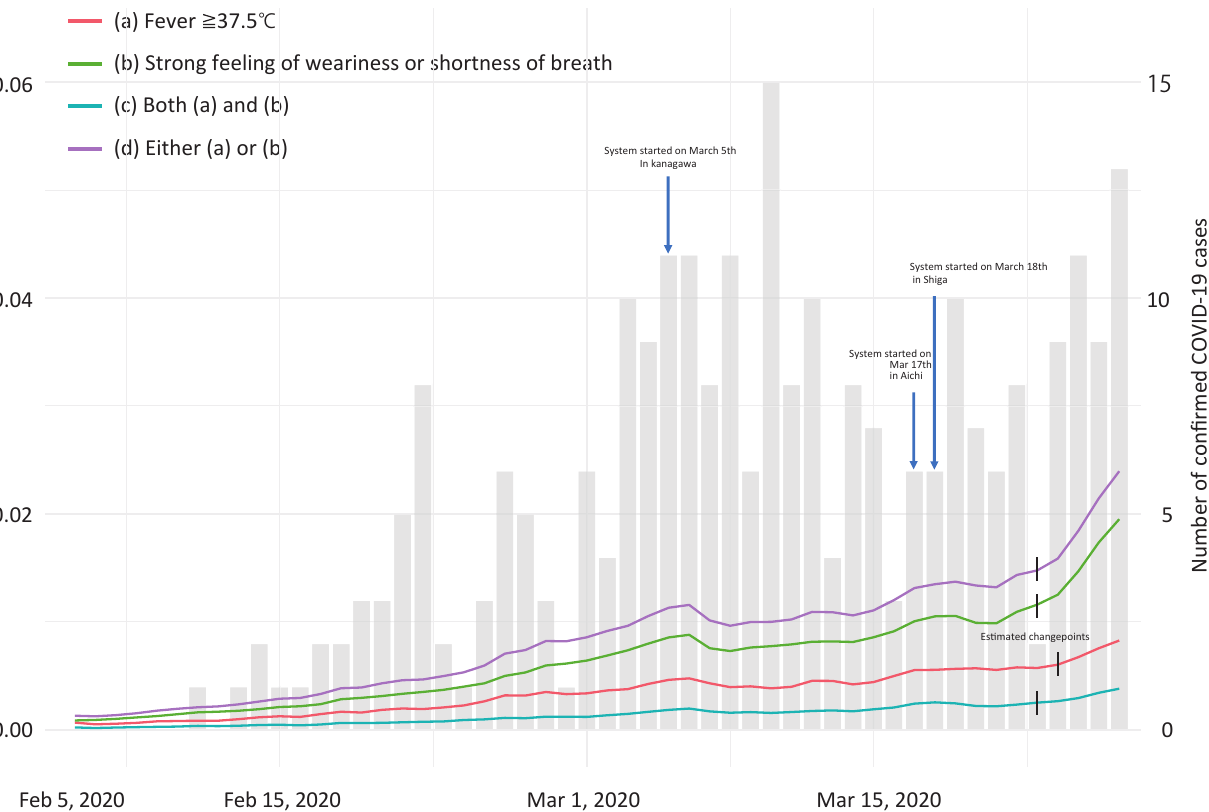
Figure 1. Trend in the proportion of non-speci fi c symptoms in three prefectures. Red line, green line, blue line, and purple line indicate the proportion of participants who have a fever (a), a strong feeling of weariness or shortness of breath (b), both (a) and (b), and either (a) or (b), respectively. Gray bars indicate the reported number of COVID-19-positive cases in three